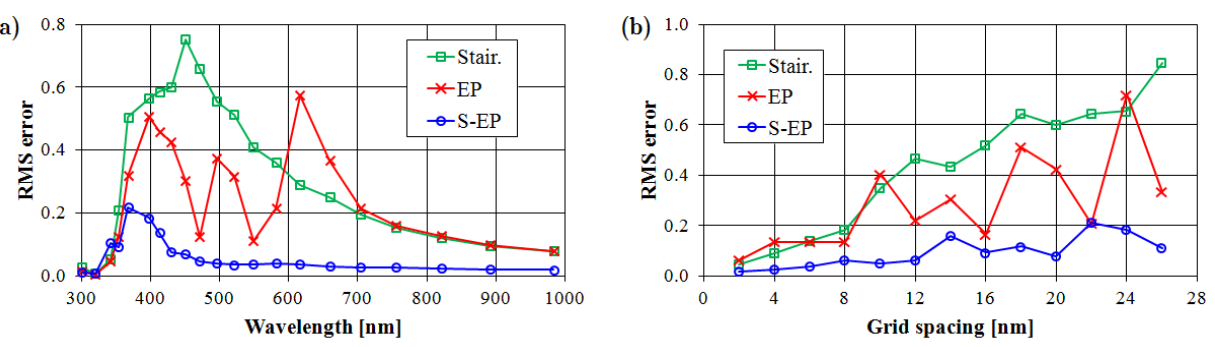
Figure 5. Root-mean-square (RMS) errors of staircase, EP, and S-EP models relative to Mie theory on contour C as a function of: ( a ) incident wavelength ( h = 20 nm, a = 538.126 nm); = 430.501 nm, a = 538.126 nm); ( c ) cylinder radius ( h = 20 nm, ( b ) grid spacing ( (cid:21) 0 (cid:21) = 430.501 nm); ( d ) subwavelength cylinder radius ( h = 10 nm, (cid:21) 0